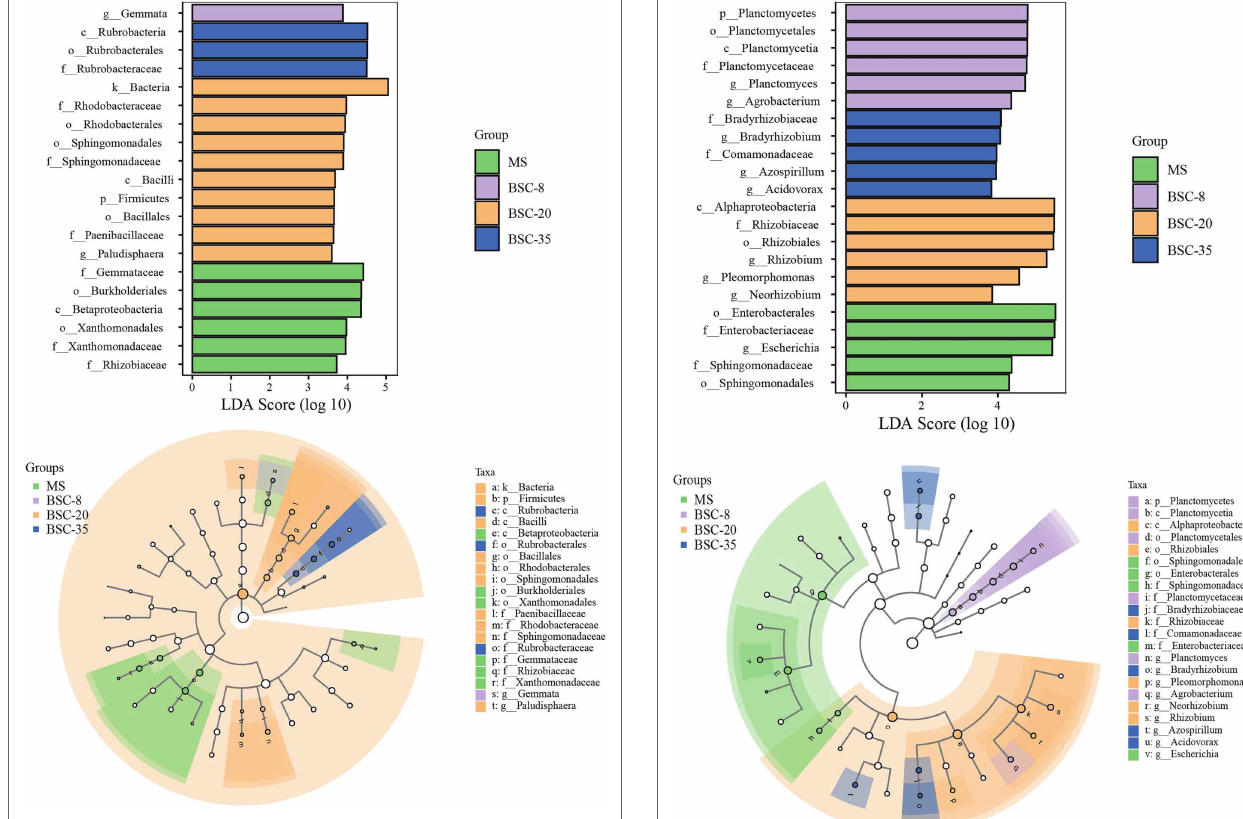
FIGURE 4 | The linear discriminant analysis (LDA) effect size (LEfSe) method identifies the significantly different abundant taxa of the phoD community across different sites. Only the taxa with average abundances of >1% were considered significant. A significance level of 0.05 and an effect size threshold of 3 were used for all evaluated biomarkers. MS, moving sand dune; BSC-8, 8-year-old biological soil crust; BSC-20, 20-year-old biological soil crust; and BSC-35, 35-year-old biological soil crust.